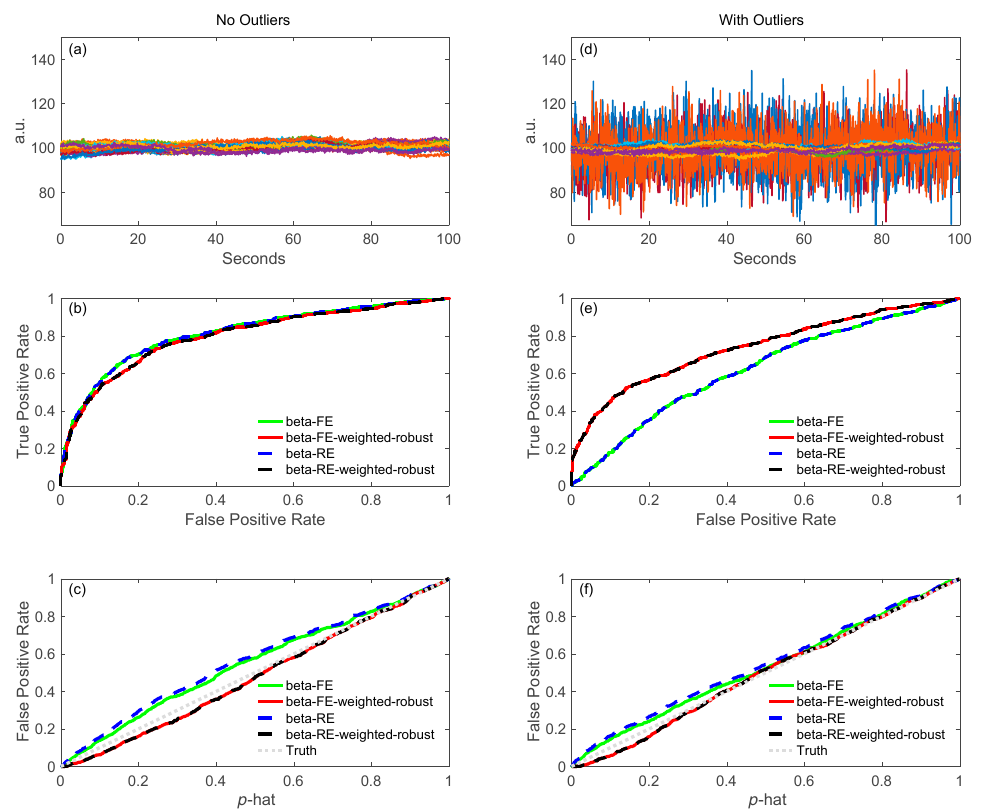
Figure 4. Group level comparison of no outliers (left column) and with outliers (right column). In panels ( a , d ), raw signals with no outliers and with outliers are shown. After simulations, the ROC curves for the various processing in the group level applied to the simulated data are shown in ( b , e ). Panels ( c , f ) show control for type-I errors for the same data and processing. An ideal curve would be along the diagonal (slope = 1), where the reported and actual FPRs would be the same.